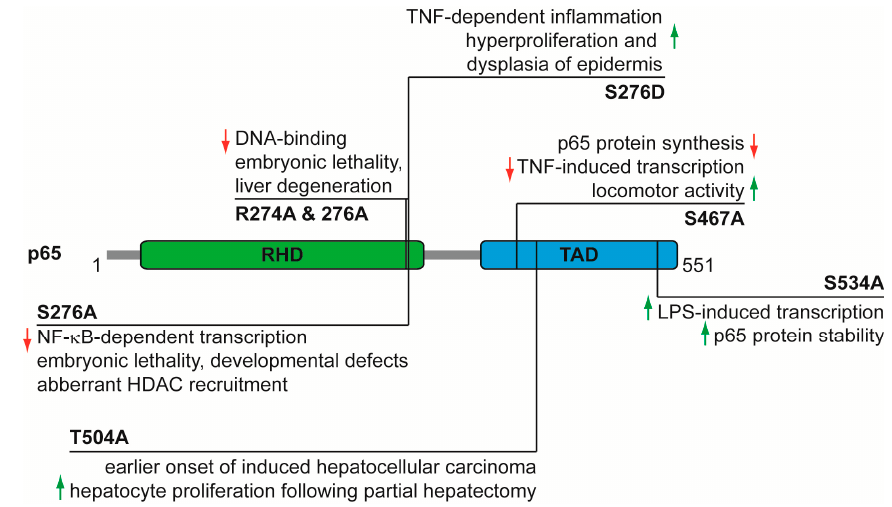
Figure 2. Schematic summary of the phenotypes of the p65 (RelA) knock-in mice mutated at the indicated phosphorylation sites.